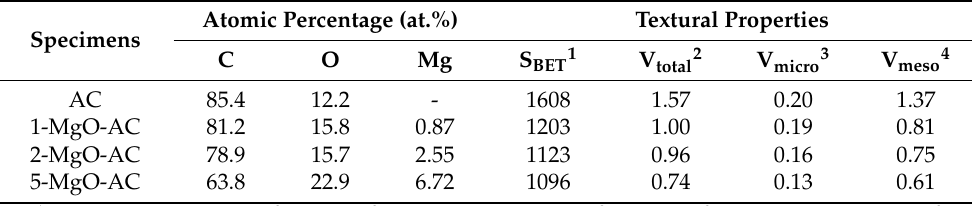
Table 1. Chemical compositions and textural properties of the MgO-coated AC samples.